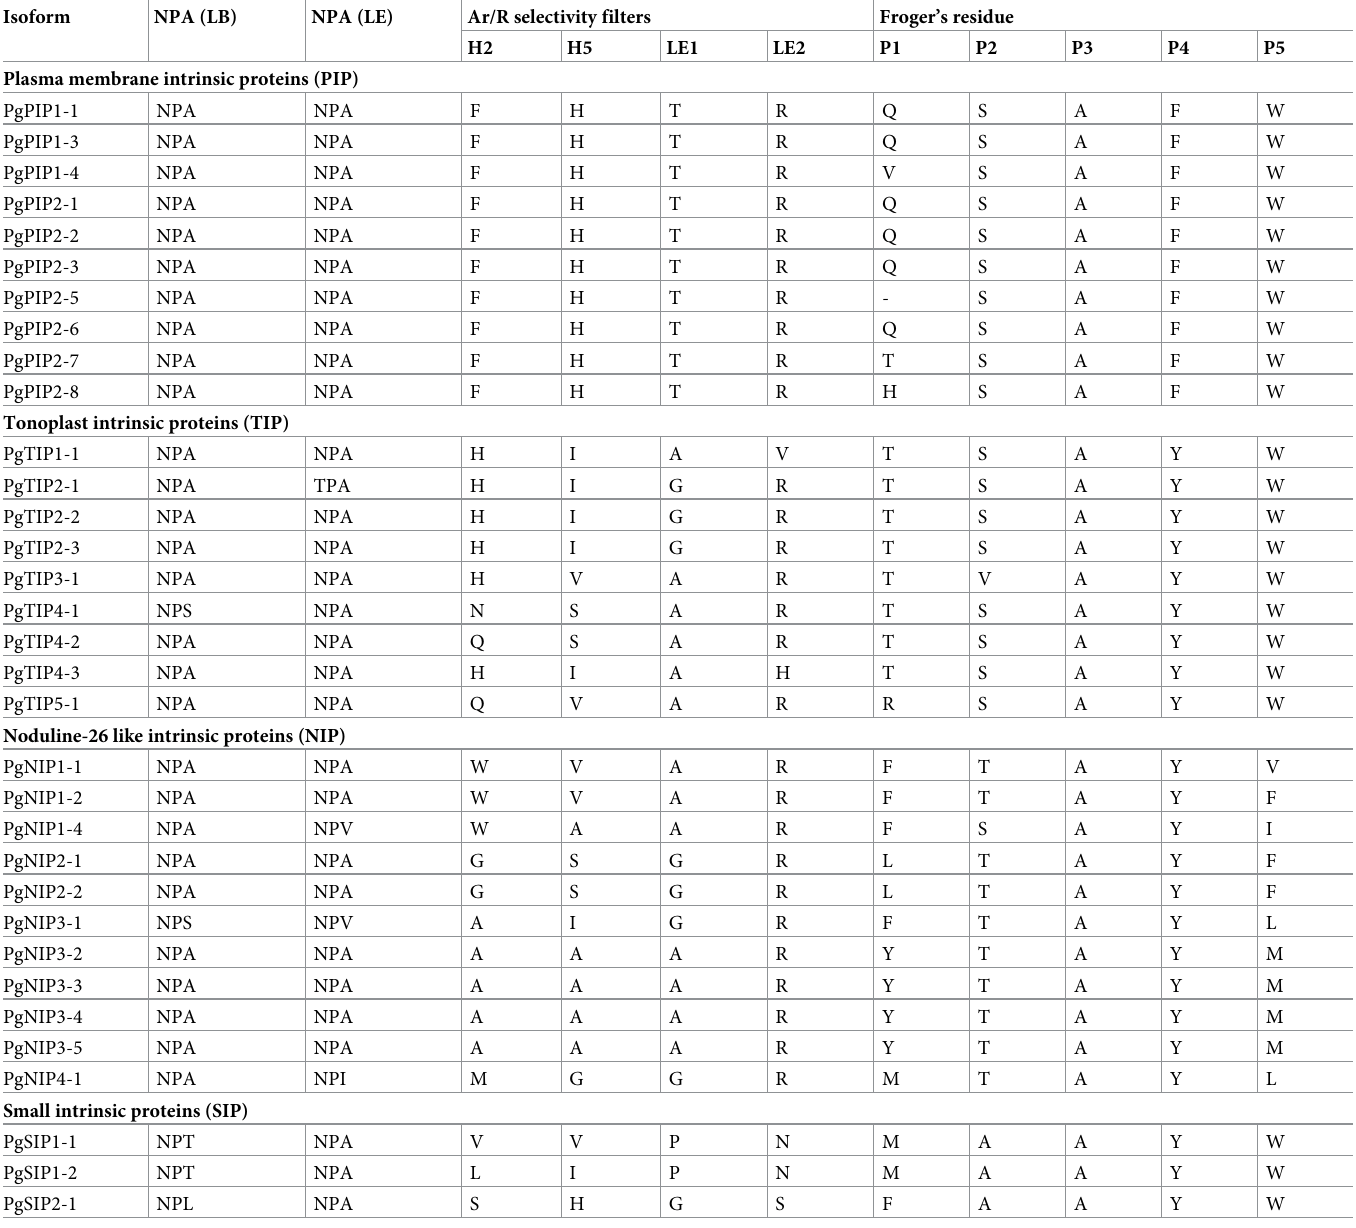
Table 2. Amino-acids residues in conserved domains of pearl millet aquaporins isoforms.